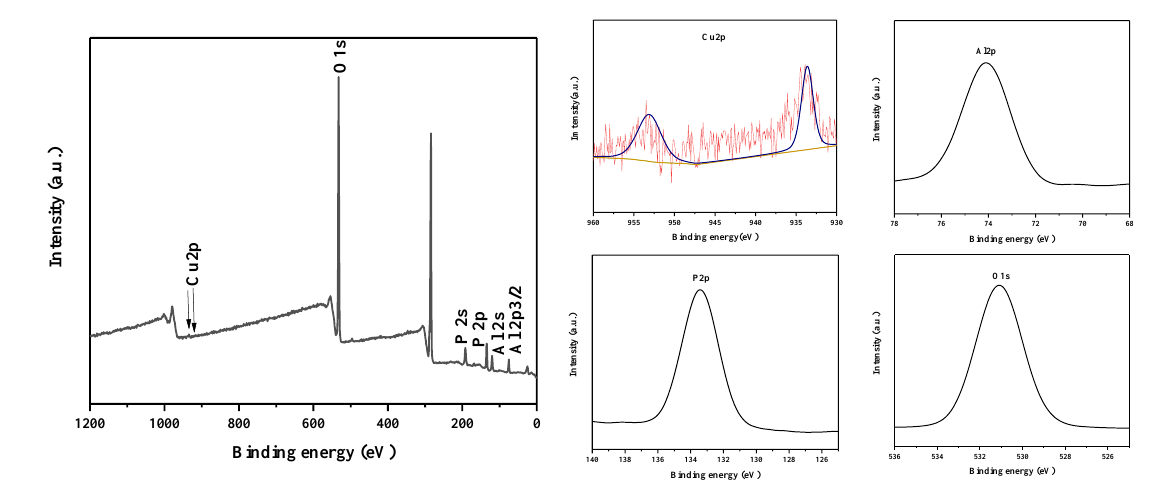
Figure 3. XPS spectrum of calcined